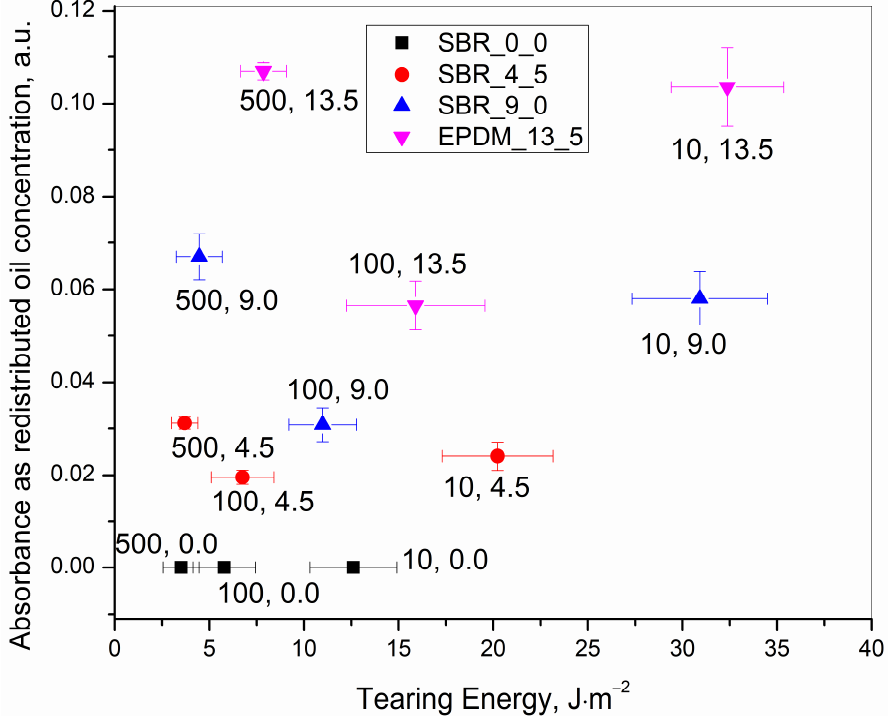
Figure 7. IR absorbance peak at 2915 cm −1 representing redistributed oil concentration after rupture as a function of calculated tearing energy at rupture for 0.0, 4.5, 9.0 and 13.5 phr of initial oil incorporated samples.